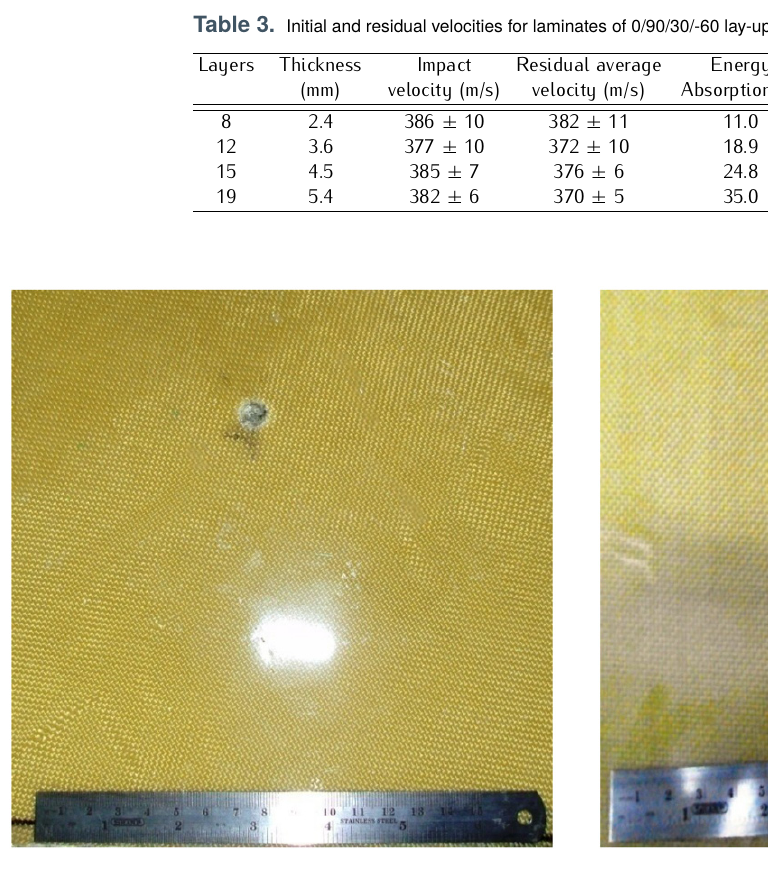
Figure 4. Damage area at front face of